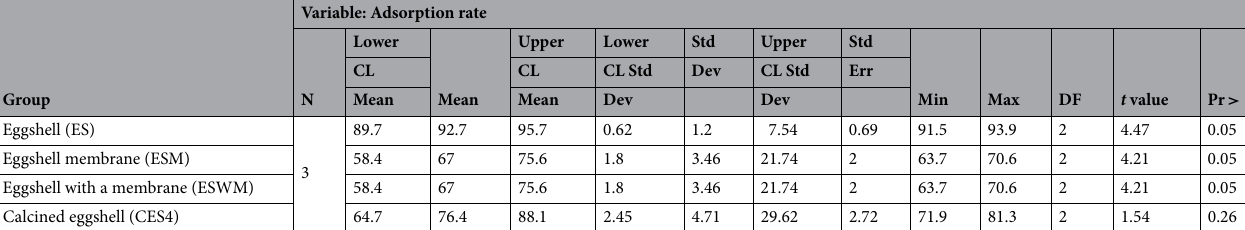
Table 4. Verification tests for the fitted model of optimum